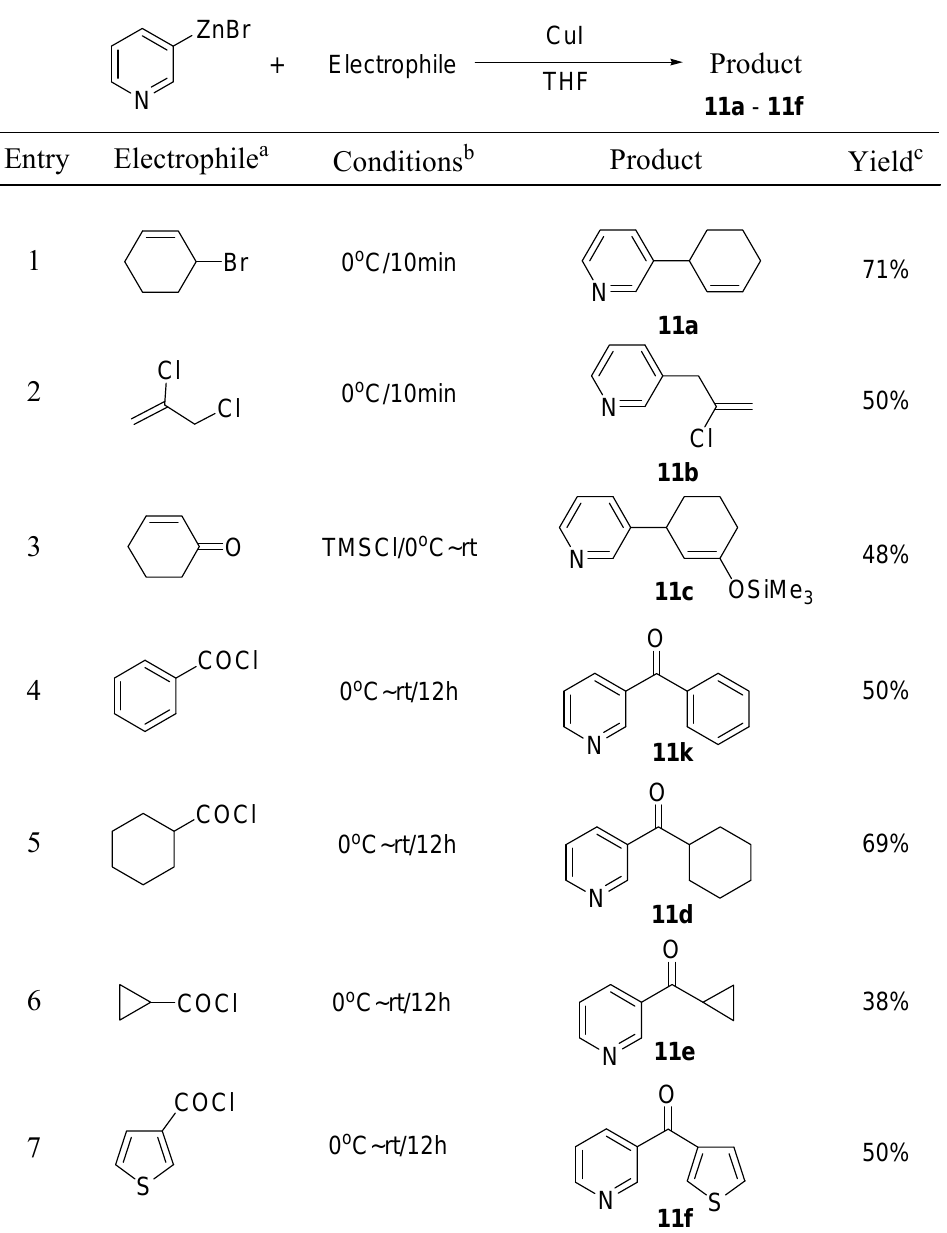
Table 11. Copper-catalyzed coupling reaction of 3-pyridylzinc